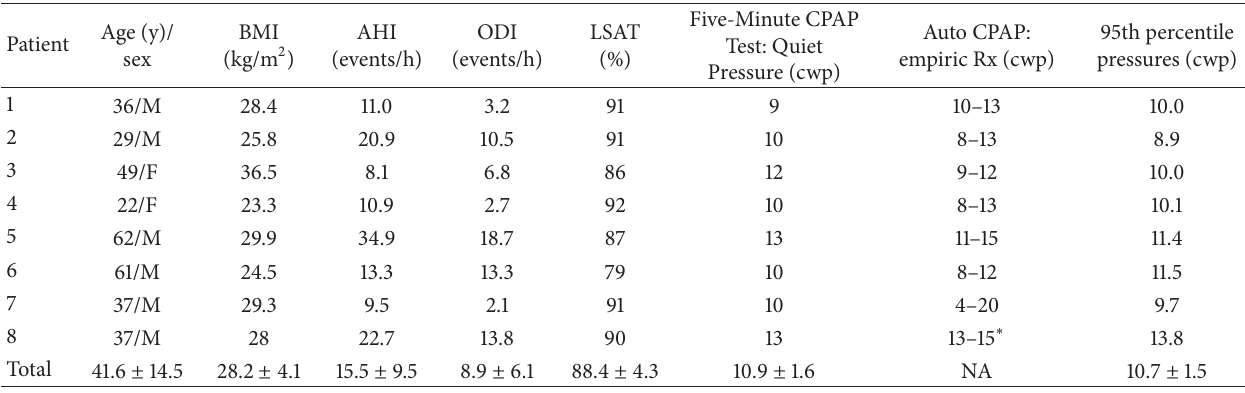
Table 3: Data for patients who underwent the Five-Minute CPAP Test and empiric prescriptions, without a CPAP titration. % = percent; AHI = apnea-hypopnea index; BMI = body mass index (in kilograms per meter 2 ); cwp = centimeters of water pressure; LSAT = lowest